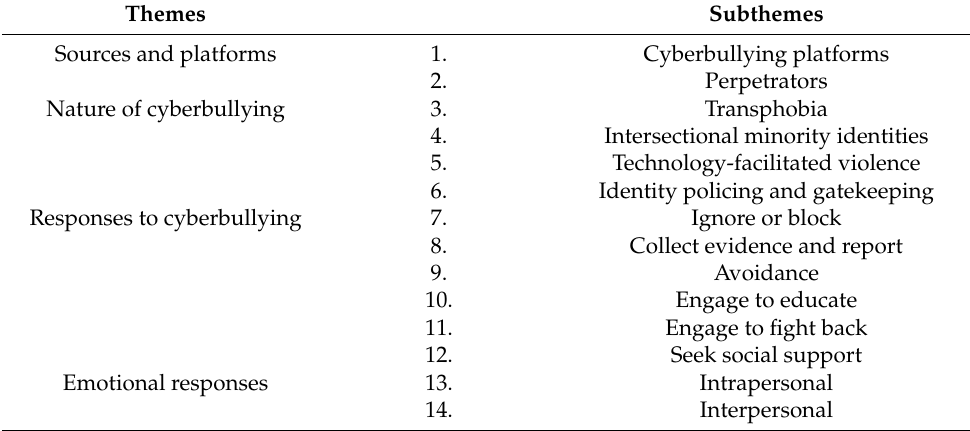
Table 1. Themes and subthemes regarding cyberbullying